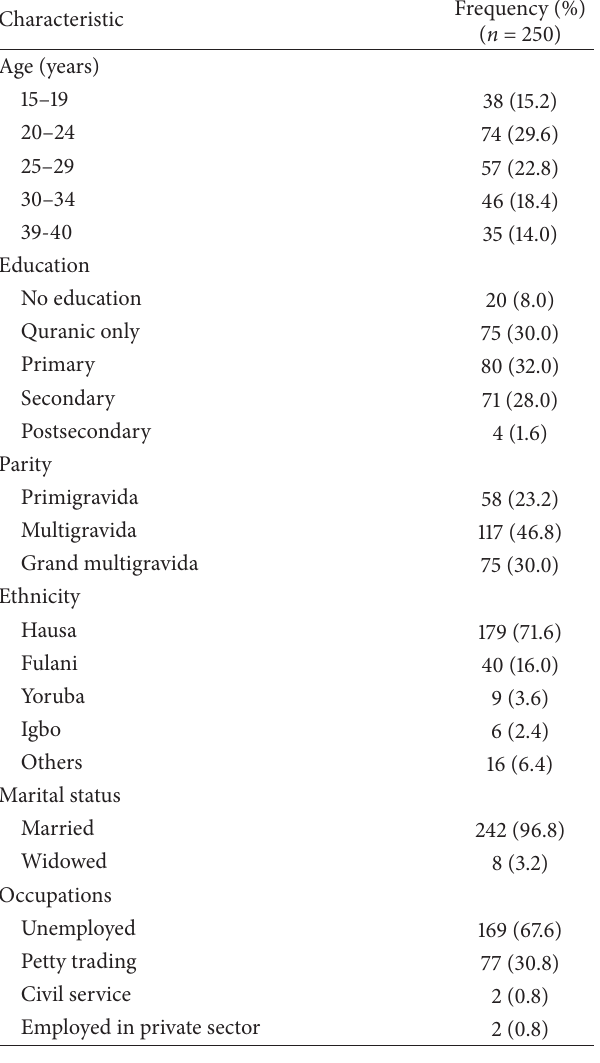
Table 1: Respondents’ social and demographic characteristics. Table 2: Assessment of the ANC clients’ perception about eclamp-